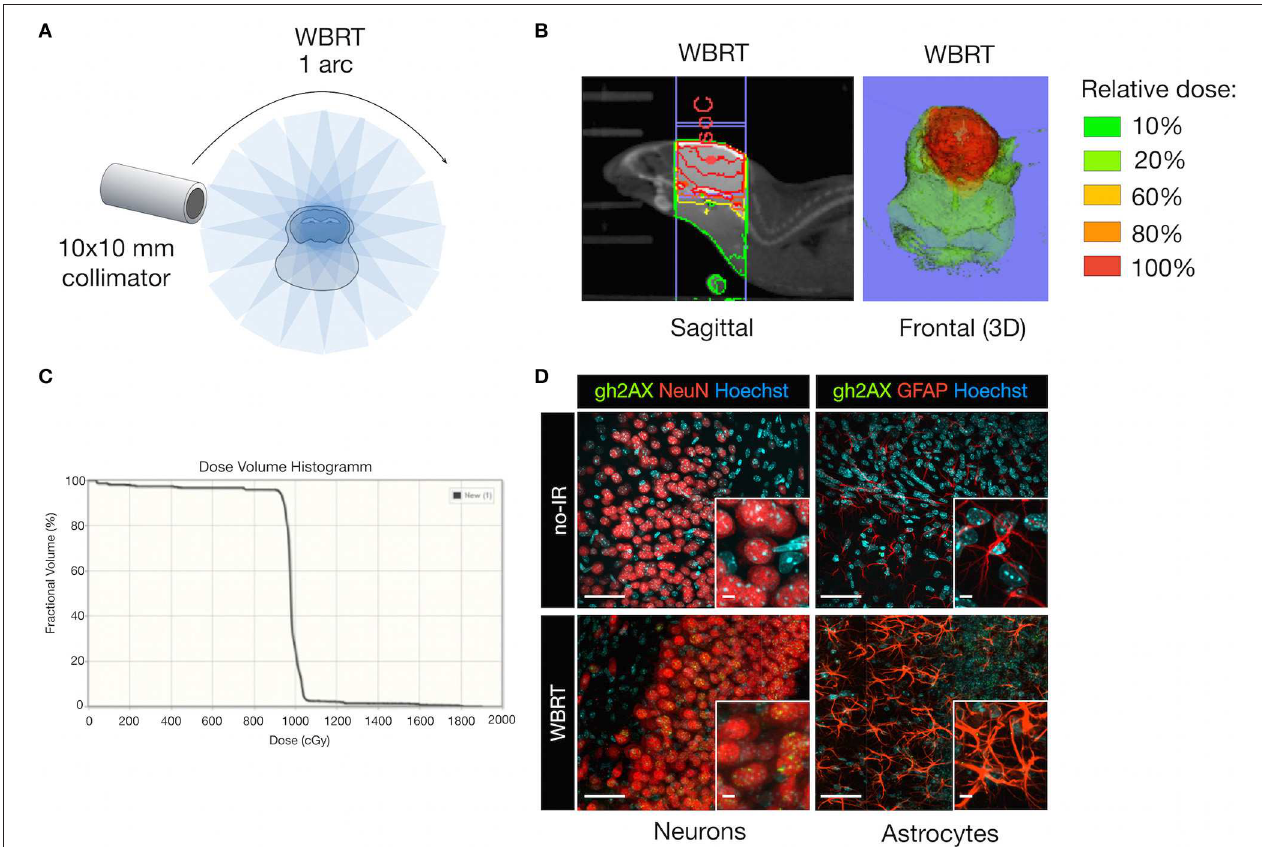
FIGURE 2 | DNA damage in brain-resident cell types in response to irradiation. (A) Schematic depicting the treatment planning of whole brain radiotherapy (WBRT) using the 10 × 10mm collimator. Radiation was applied as a single dose of 10Gy using 1 arc. (B) Representative image of the dose distribution in the target region. The isocenter (IsoC) is depicted by the red dot. Color shades visualize the distribution of the relative dose. Shown is a sagittal view (left panel) and a three-dimensional (3D) reconstruction of the frontal view. (C) Dose volume histogram indicating the percentage of fractional volume over the radiation dose in cGy. (D) Representative images of γ H2AX expression (green, lower panel) in NeuN + neurons (red; left lower panel), GFAP + astrocytes (red; right lower panel) on cleared thick brain sections 6h after WBRT. Controls without WBRT are shown in the upper panel. Hoechst was used as nuclear counterstain. Scale bars indicate 50 and 5 µ m.